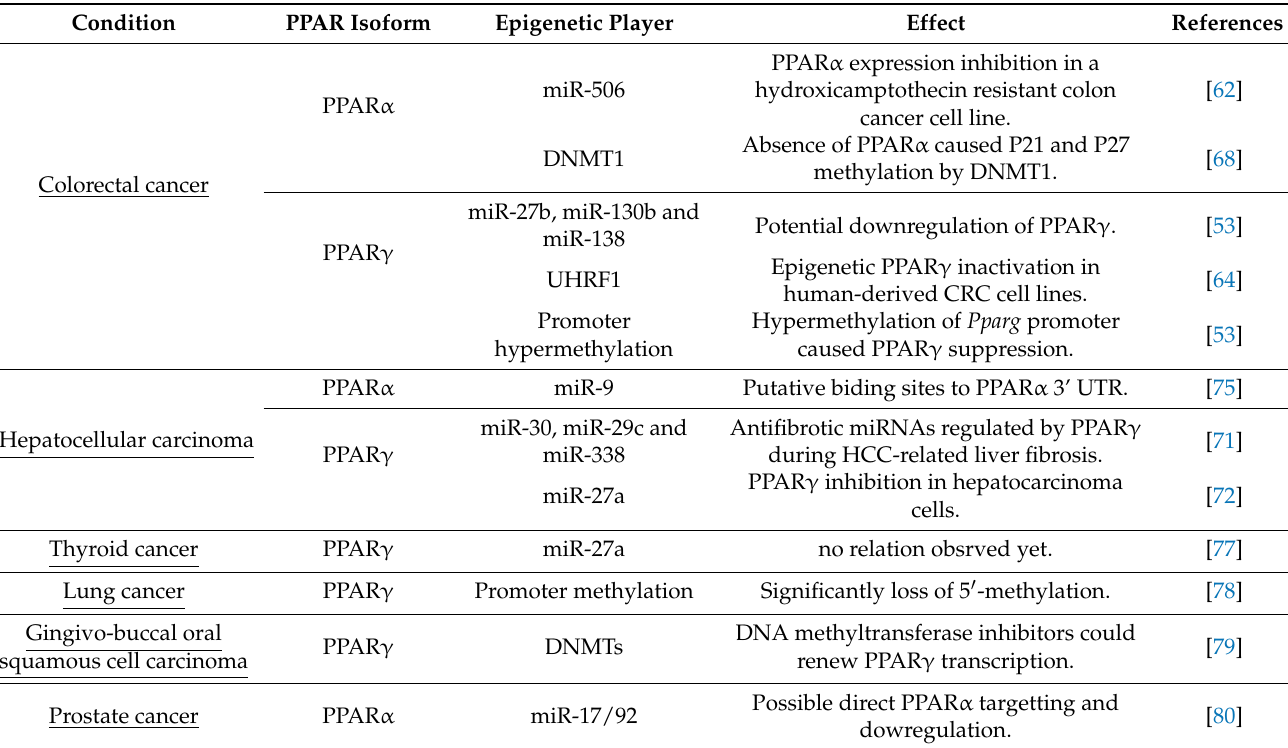
Table 1. PPAR epigenetics in different